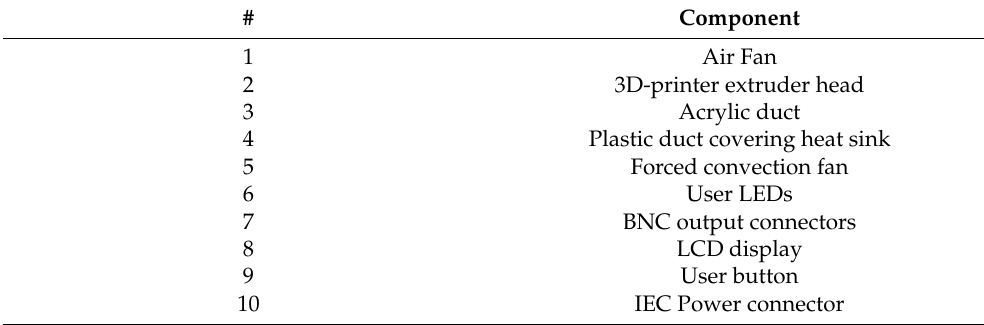
Table 1. Deusto Heater Experimental Setup—List of the main external components of the prototype.